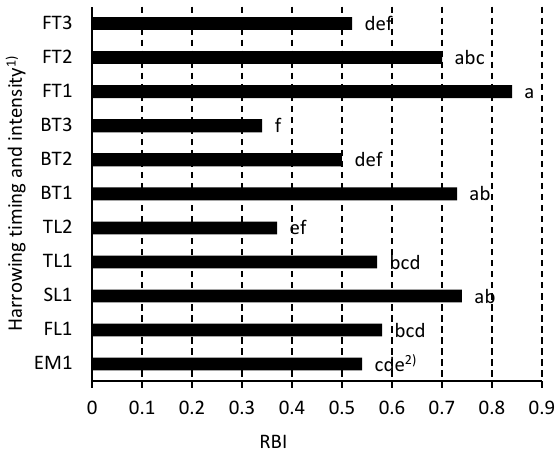
Fig. 1. Resistance to burial index (RBI) of triticale-lupin mixture. Means averaged over 2015–2017. 1) Letters to the left of the vertical axis indicate growth stages of triticale while numbers denote the number of passes with a harrow per plot; EM=plant emergence, FL=first leaf unfolded, S=second leaf unfolded, TL=third leaf unfolded; BT=beginning of tillering; FT=full tillering; 2) Bars sharing a common letter are not significantly different at the 5% probability